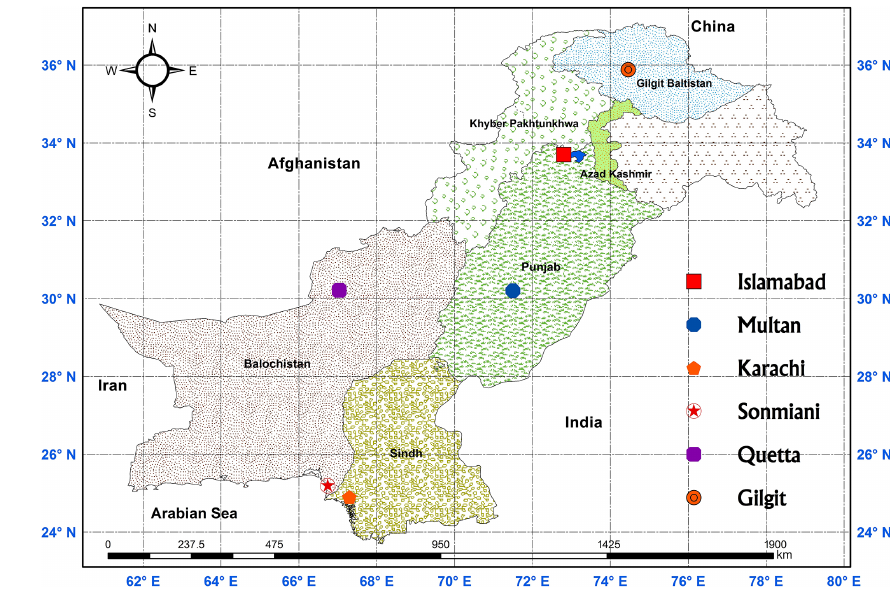
Figure 1. Geographical locations of ionospheric and geomagnetic observatories in Pakistan.